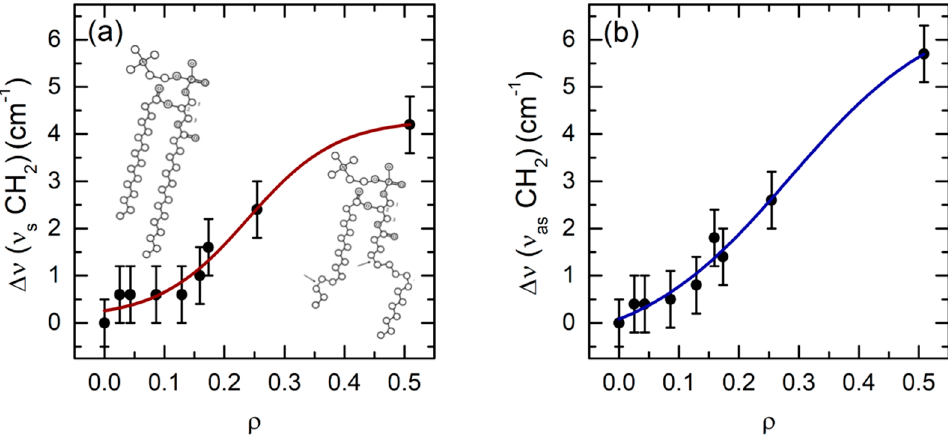
Figure 3. Frequency shift ∆ ν (in cm − 1 ) as a function of ρ : ( a ) peak at 2855 cm − 1 , ascribed to CH 2 symmetric stretching mode, with sketches of trans/gauche CL conformers; ( b ) peak at 2927 cm − 1 , assigned to CH 2 antisymmetric stretching mode. Data were fitted by sigmoidal curves (shown as guides to the eye) and reported on the same